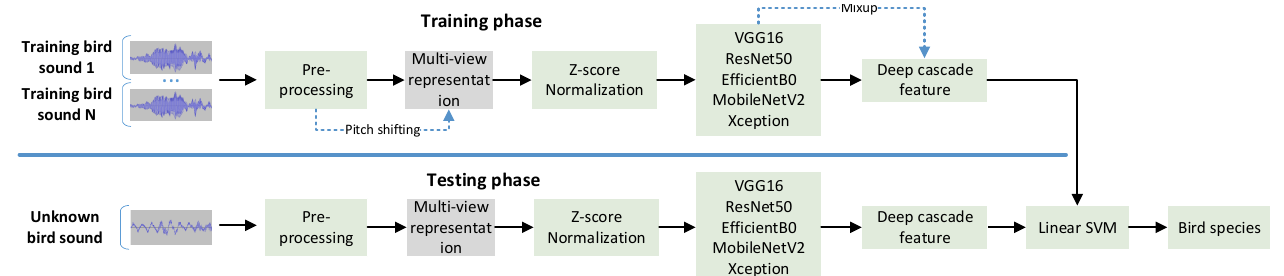
Figure 1. The flow diagram of our proposed approach. Here, data augmentation is only applied in the training